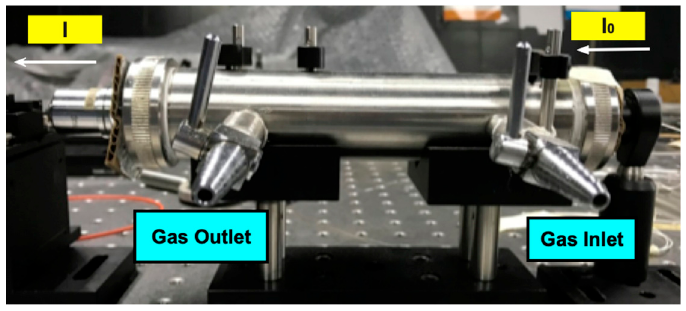
Figure 4. Gas cell.